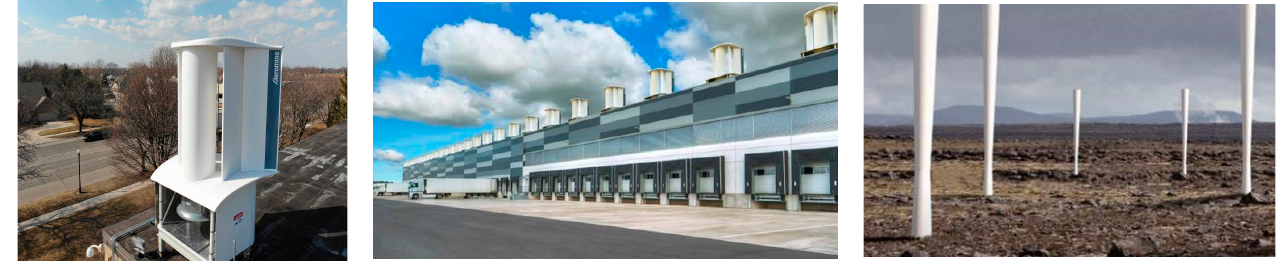
Figure 17. New vertical rooftop windmills [35,39].